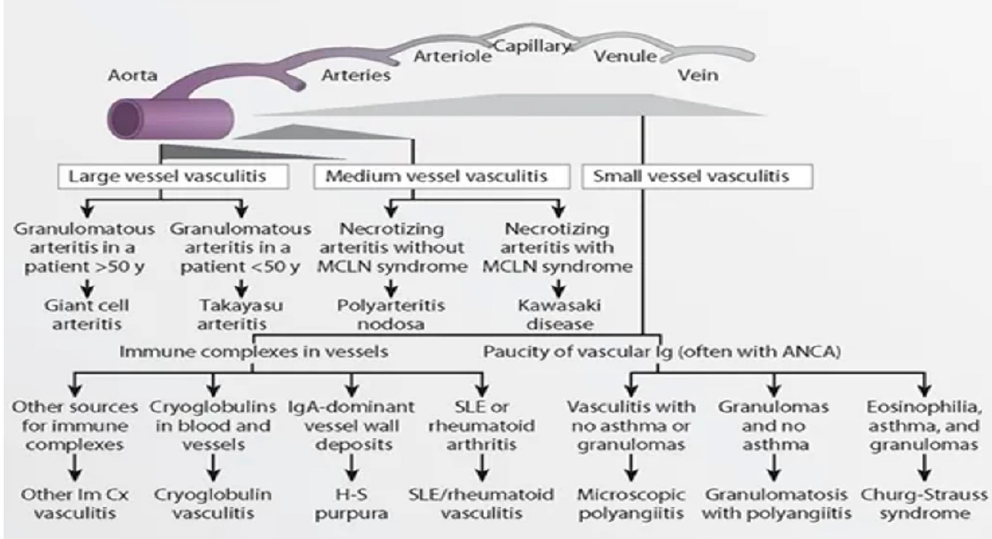
Figure 12. Figure shows the Chapel Hill classification of retinal vasculitis. (Permission obtained for